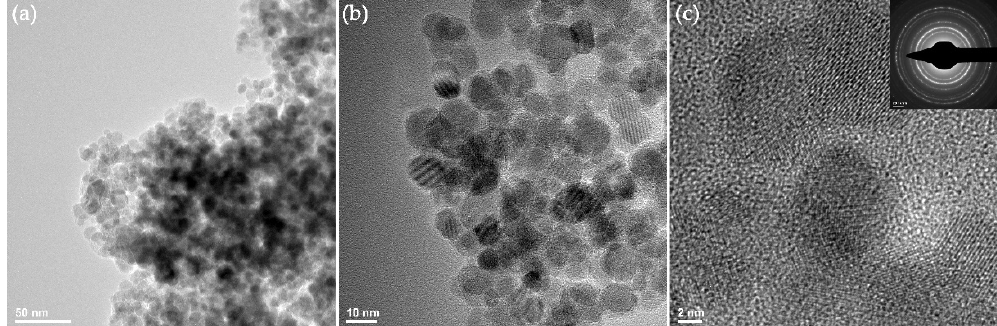
Figure 4. Transmission electron microscopy (TEM) ( a , b ) and HR-TEM ( c ) micrographs, and selected area electron diffraction (SAED) pattern (inset) of Fe 3 O 4 @EG particles.